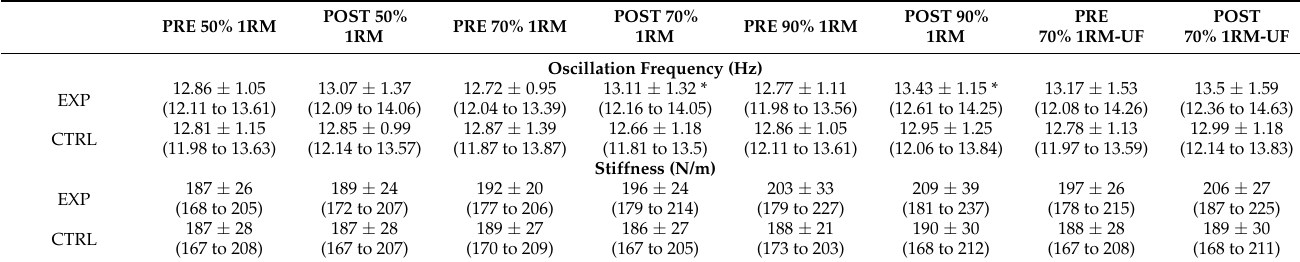
Table 2. Muscle mechanical properties responses of triceps brachii long head to the different loads of the bench press exercise.